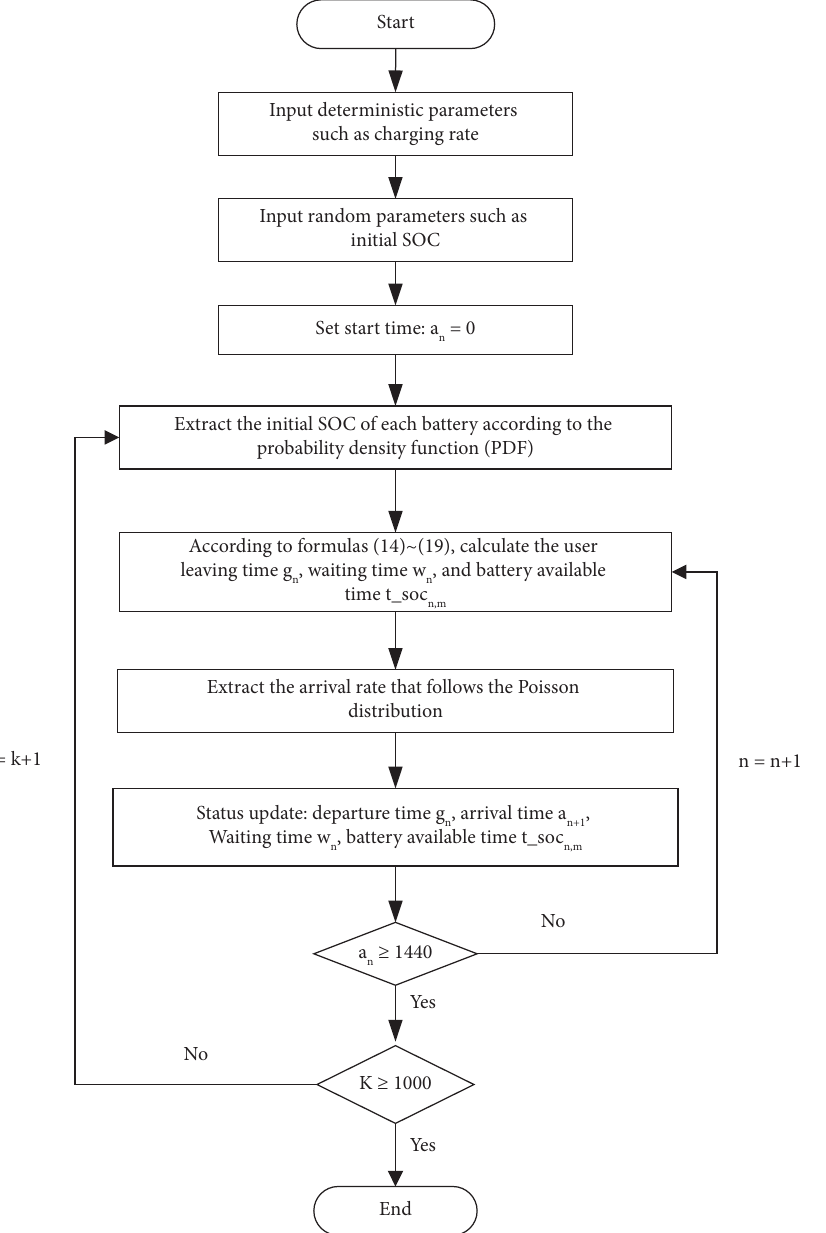
Figure 10: Simulation process based on the Monte Carlo